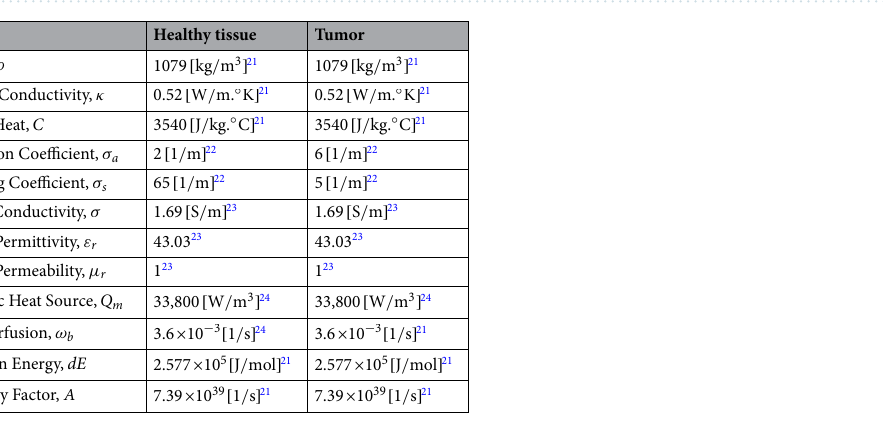
Table 1. Thermal and optical properties of liver (healthy and cancerous tissue).